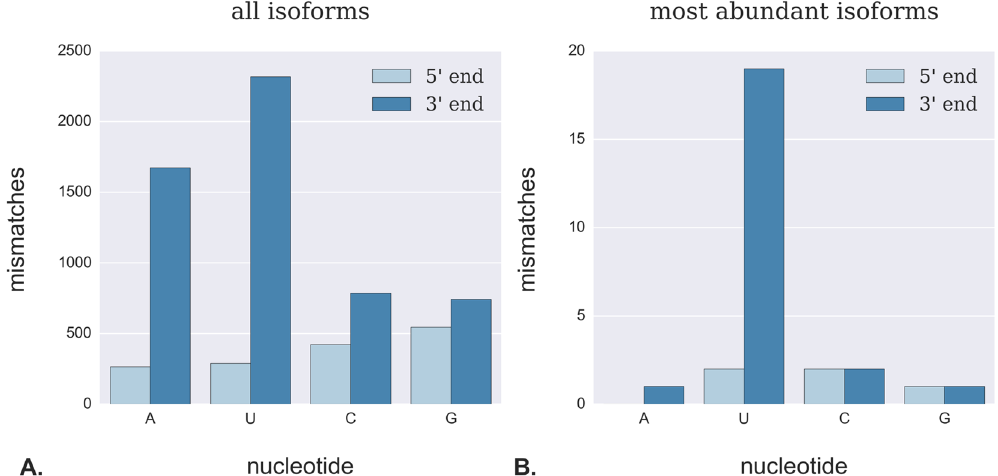
Figure 8. Approximately one in five reads featured a nucleotide mismatch relative to the reference horse genome. ( A ) Amongst the total collection of reads detected in the six samples (45174 different sequences), mismatches at the 3 ′ end of the read were considerably more abundant than mismatches at the 5 ′ end. Furthermore, mismatching 3 ′ nucleotides were more likely to be either uridine (U) or adenine (A) than cytosine (C) or guanine (G). ( B ) When the most-abundant isoforms of each miRNA (300 different sequences) were considered separately, a similar trend was observed but with a dramatic increase in the proportion of mismatches due to non-templated 3 ′ U